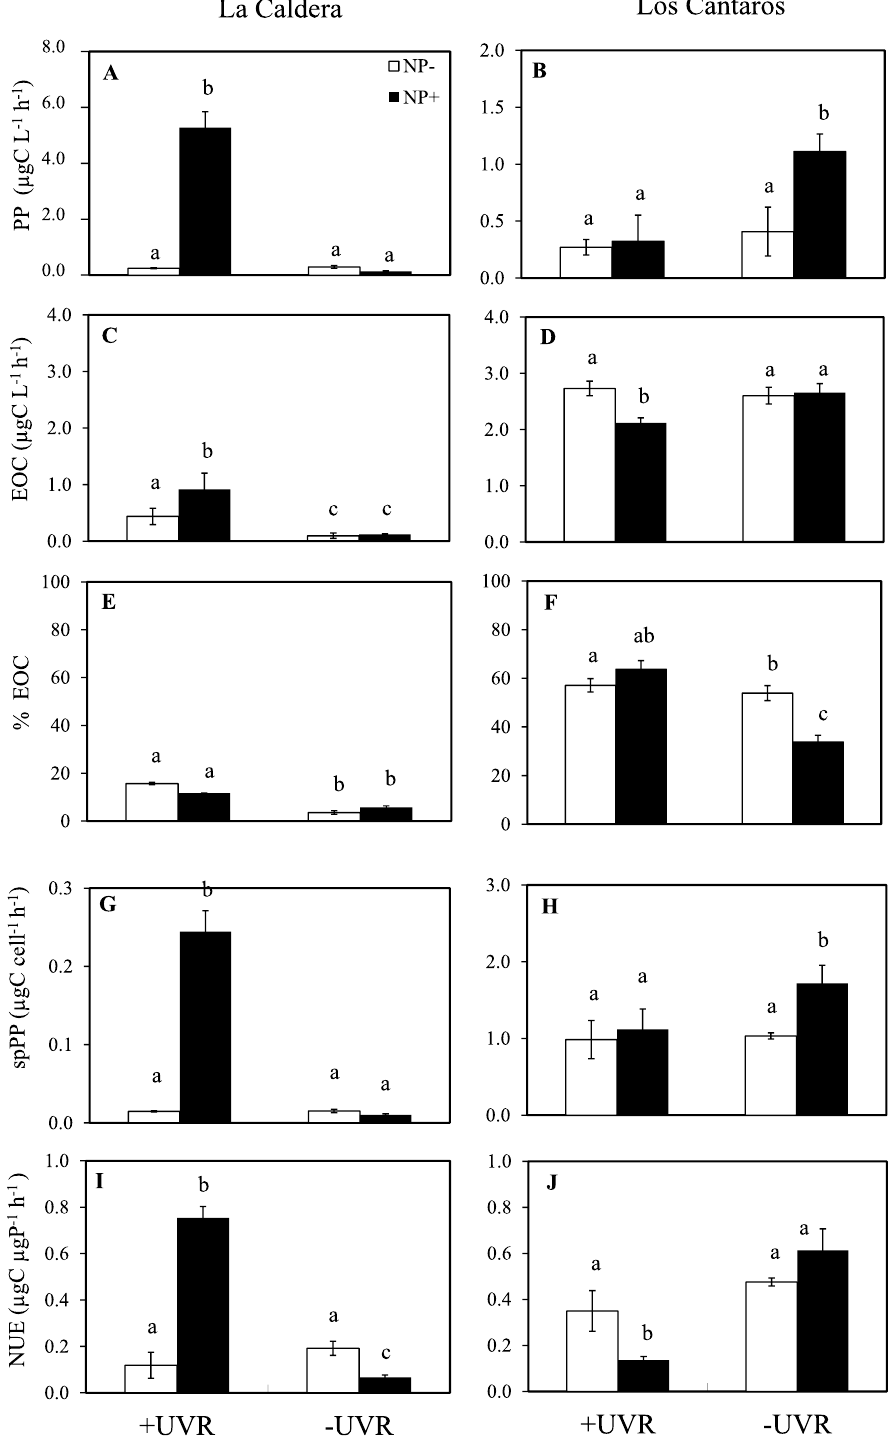
Figure 4. Metabolic variables of the phytoplankton community under the experimental conditions. Primary production, excreted organic carbon (%) and productivity under radiation [full sunlight ( + UVR) and photosynthetically active radiation ( − UVR)] and nutrient treatments [nutrient-enriched (NP + ) and non- enriched (NP − )] in La Caldera and Los Cántaros lakes. Primary production (PP) ( A , B ); excretion of organic carbon rates (EOC) ( C , D ); percentage of excretion of organic carbon (%EOC) ( E , F ); specific cell productivity (spPP) ( G , H ); photosynthetic nutrient-use efficiency (PNUE) ( I , J ). Data are expressed as mean values ± SD (n = 3). Significant differences among treatments are denoted by different lower-case